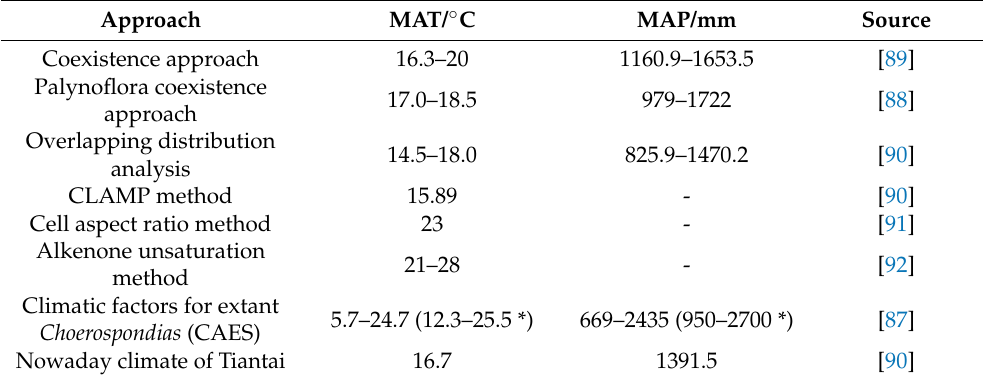
Table 3. Late Miocene climatic values reconstructed by different methods and nowadays values in Tiantai region, eastern